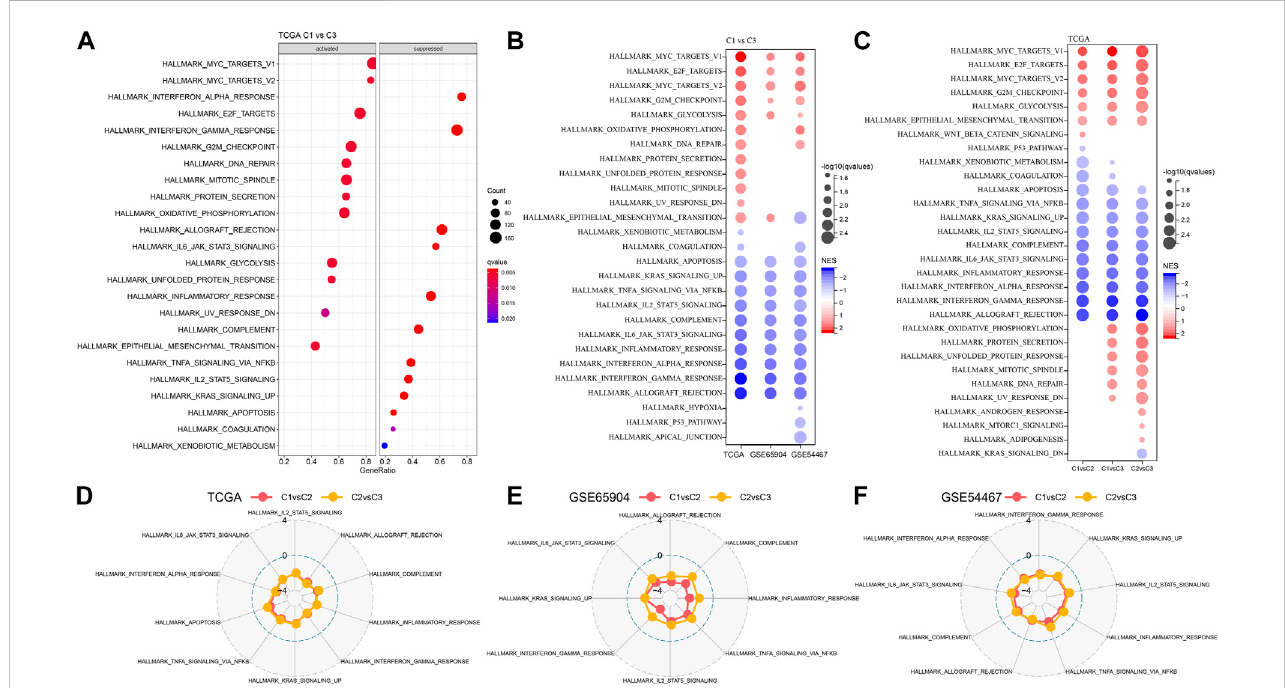
FIGURE 5 Different molecular subtypes pathway analysis. (A) Results of GSEA analysis of C1 vs. C3 in the TCGA-SKCM cohort. (B) Bubble plot of GSEA analysis of C1 vs. C3 subtypes in the three cutaneous melanoma cohorts. (C) Different molecular subtypes in the TCGA-SKCM cohort. (D – F) Radar plots indicating NESs of Hallmark pathways calculated through a gene set enrichment analysis (GSEA) of cluster 1 versus cluster 2 and of cluster 2 versus cluster 3 in the TCGA cohort, GSE69504 cohort, and GSE54467